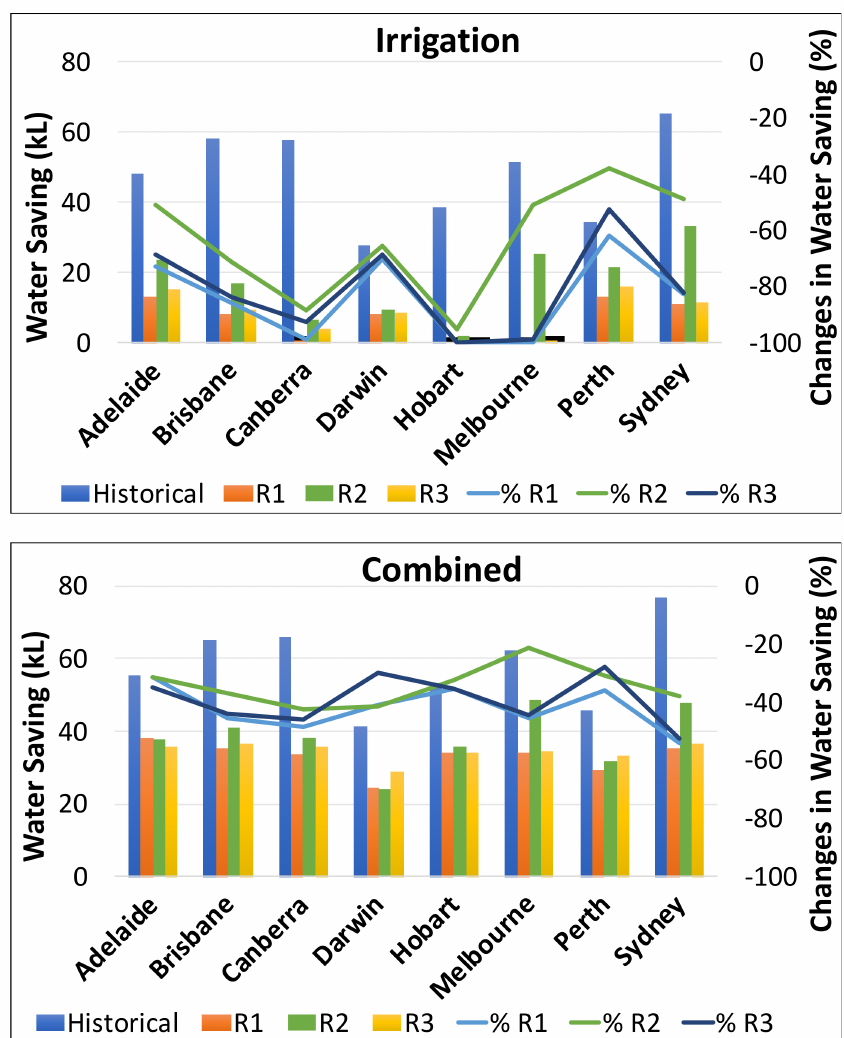
Figure 10. Average annual water savings and percent changes pattern for both the historical and future period for TLD, irrigation and combined